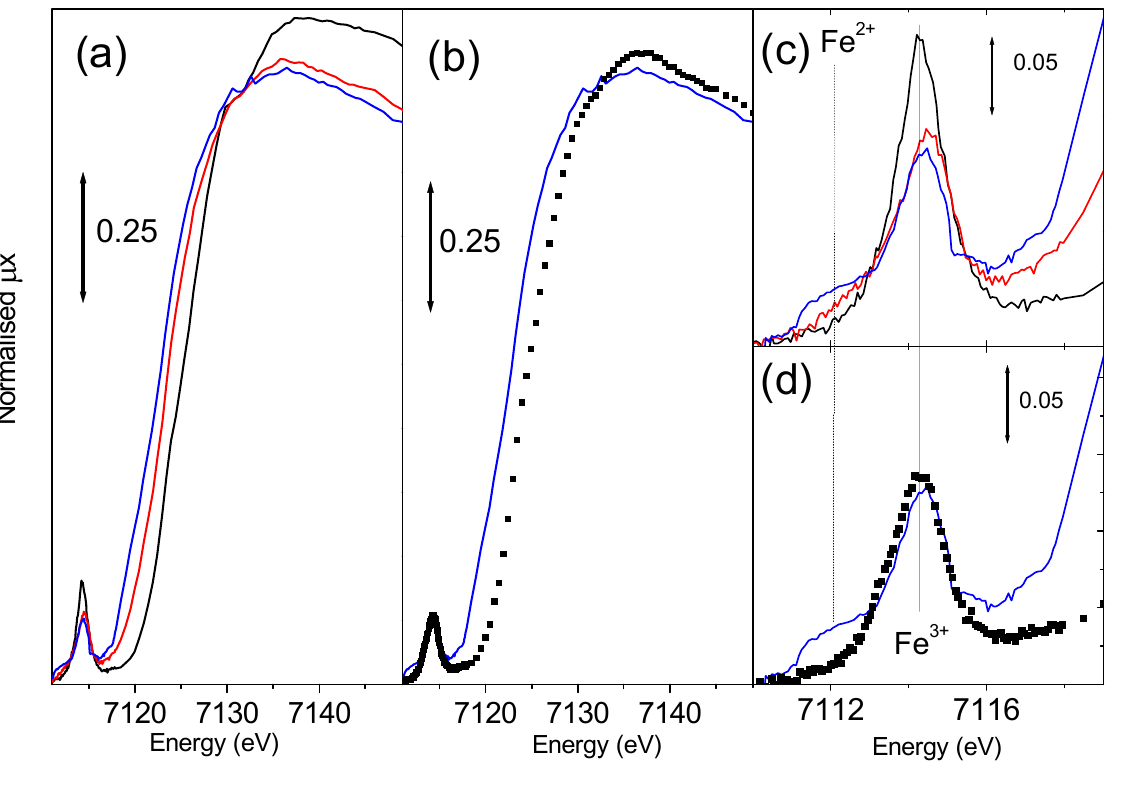
Figure 8: Parts (a) and (b): as corresponding parts of Figure 7 for XANES spectroscopy. Parts